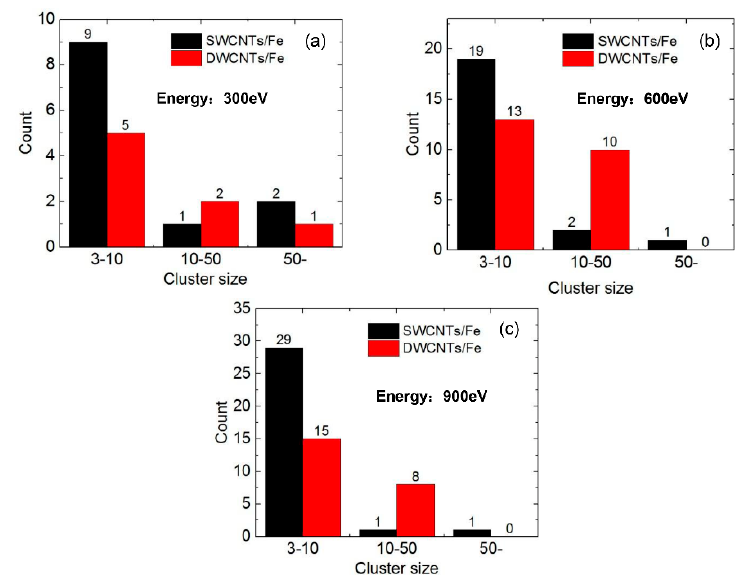
Figure 9. The number of He clusters in SWCNT/Fe and DWCNT/Fe composites, t = 1400 ps. The incident energies of the He atoms were ( a ) 300 eV; ( b ) 600 eV; and ( c ) 900